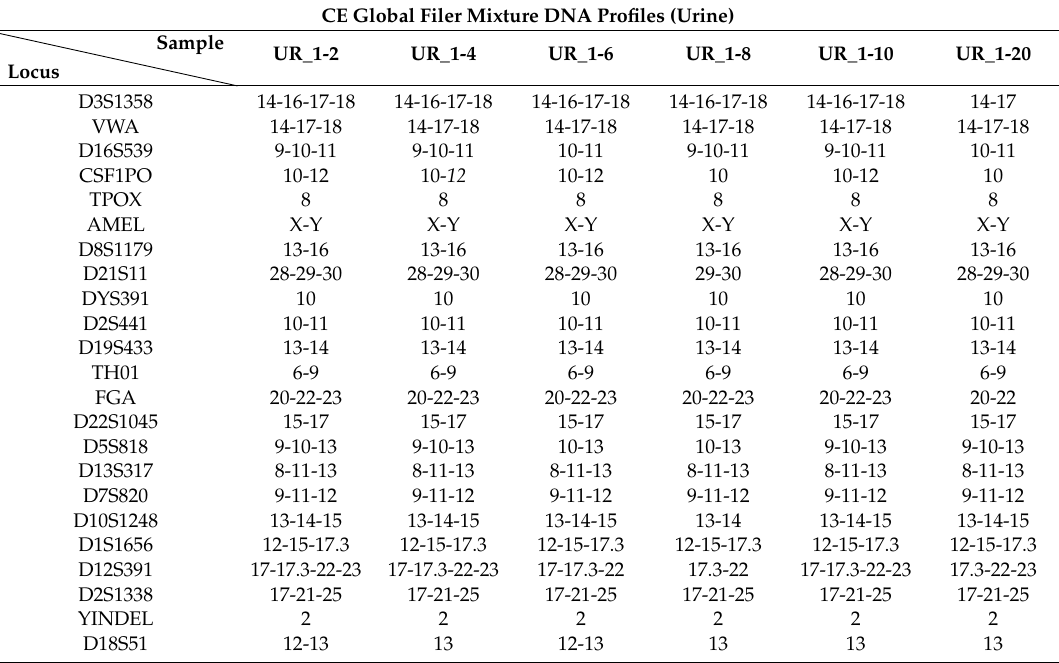
Table 4. Genotyping results for the urine-mixture samples. CE: Capillary Electrophoresis. CE Global Filer Mixture DNA Profiles (Urine)